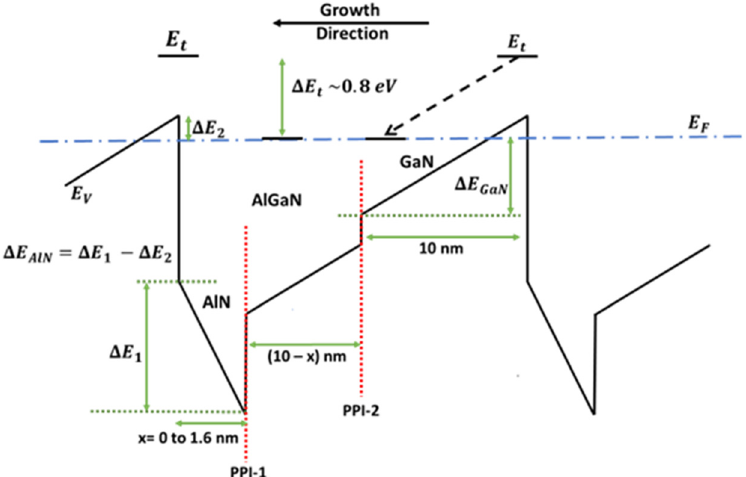
Figure 6. A model valence band diagram schematic for a single p-type AlN/AlGaN/GaN SL period with low Mg doping. E t is the indicated acceptor trap level, with Δ E t = ~0.8 eV measured from the valence band ( E V ) of GaN. The arrow from E t indicates how the trap energy follows the band-bending and is just a guide to the eye. Δ E (AlN) (= Δ E 1 − Δ E 2 ≈ Δ E 1 ) refers to band-bending in the AlN layer at the AlN/AlGaN interface, and Δ E (GaN) refers to band-bending in the GaN layer at the GaN/AlGaN interface. The vertical dotted lines indicate the two positive polarization interfaces (PPIs), in this case AlGaN/AlN (PPI-1) and GaN/AlGaN (PPI-2). The separation of these interfaces from the 2DHG is also shown in the diagram, and we used the reduced impact of hole mobility of traps ionized at PPI-2 (relative to PPI-1) because of the larger distance from the hole gas in order to support the analysis.